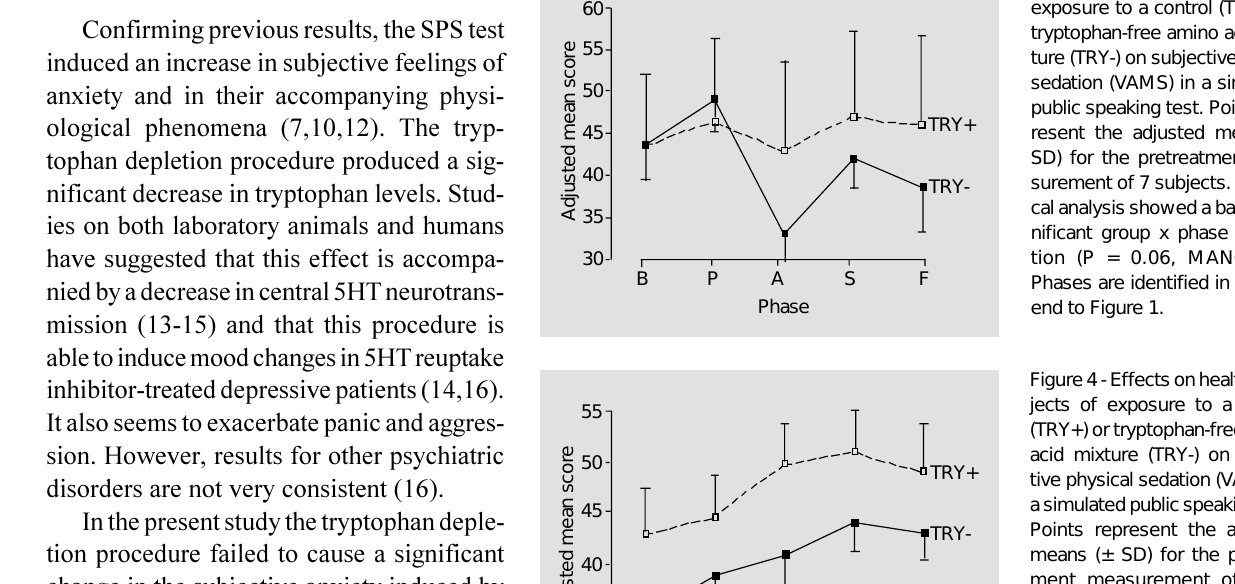
Figure 4 - Effects on healthy sub- jects of exposure to a control (TRY+) or tryptophan-free amino acid mixture (TRY-) on subjec- tive physical sedation (VAMS) in a simulated public speaking test. Points represent the adjusted means (± SD) for the pretreat- ment measurement of 14-15 subjects. Statistical analysis showed a significant group dif- ference during the whole test (P<0.05, MANCOVA). Phases are identified in the legend to Figure 1. Figure 5 - Effects on healthy subjects of exposure to a con- trol (TRY+) or tryptophan-free amino acid mixture (TRY-) on other feelings and attitudes (VAMS) in a simulated public speaking test. Points represent the adjusted means (± SD) for the pretreatment measurement of 14-15 subjects. Statistical a- nalysis showed a trend to a significant group difference dur- ing the whole test (P<0.10, MANCOVA). Phases are identi- fied in the legend to Figure